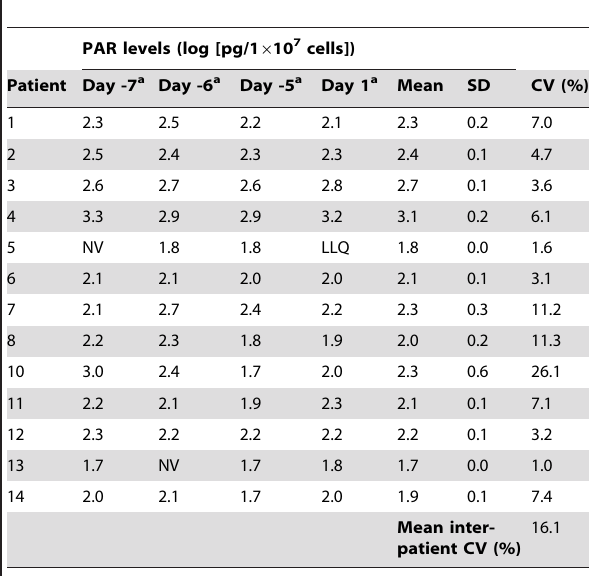
Table 4. PAR levels in PBMCs collected from patients during the Phase 0 clinical trial of